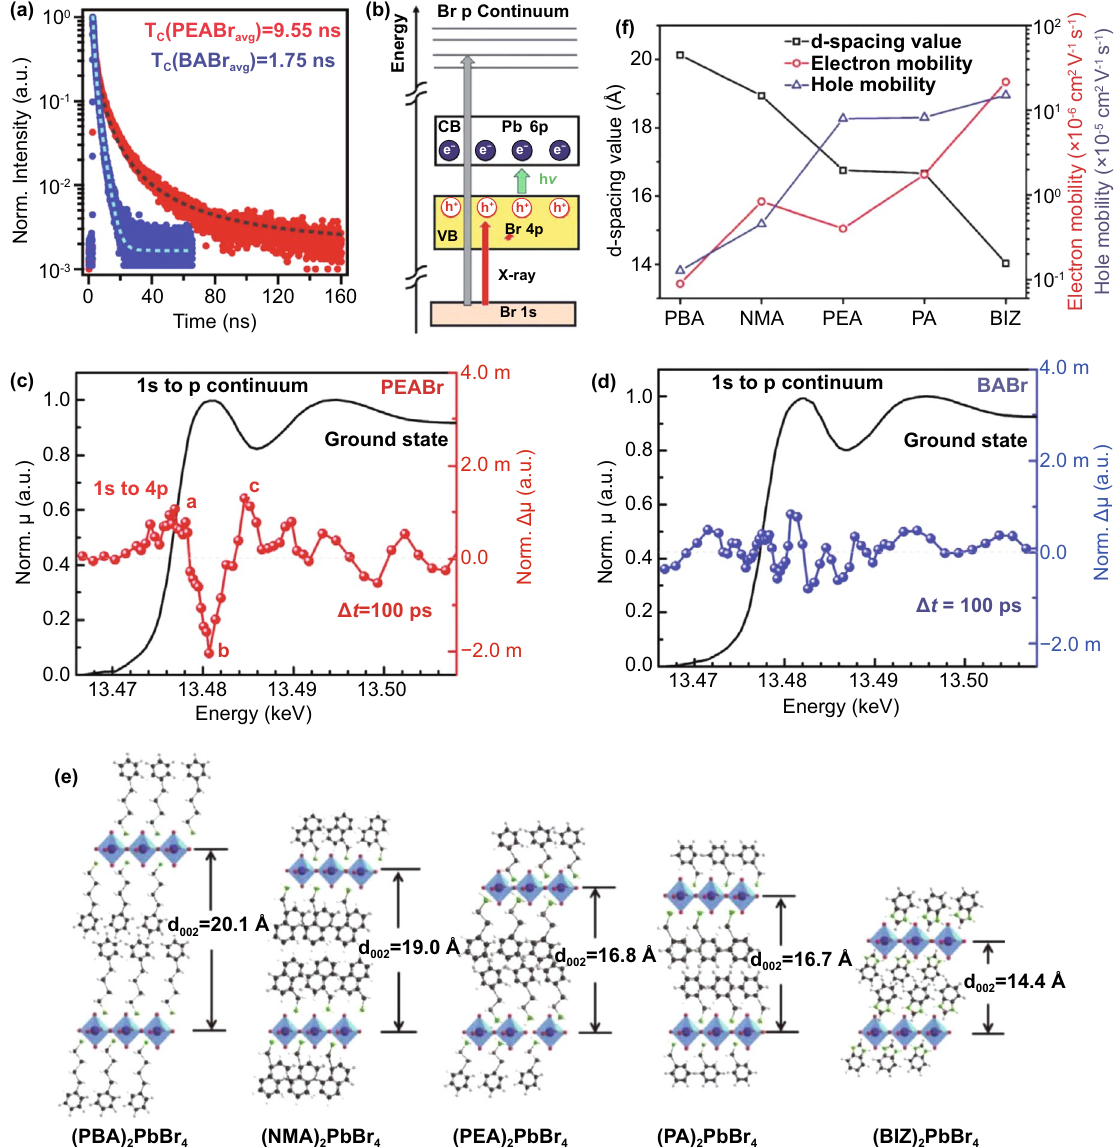
Fig. 9 a Time-resolved PL decay curves for PEABr and BABr thin films. b Schematic illustration of bromide (Br) K near edge transitions. The ground-state X-ray absorption spectra as a function of energy and the change in X-ray absorption after 100 ps laser excitation for c PEABr and d BABr thin films. Copyright 2020 Wiley–VCH Verlag [123]. e Schematic representation of the barrier width of (PBA) 2 PbBr 4 , (NMA) 2 PbBr 4 , (PEA) 2 PbBr 4 , (PA) 2 PbBr 4 and (BIZ) 2 PbBr 4 perovskite films. f Electron and hole mobilities versus d-spacing value of perovskite films with vari- ous organic cations. Copyright 2019 John Wiley and Sons Inc